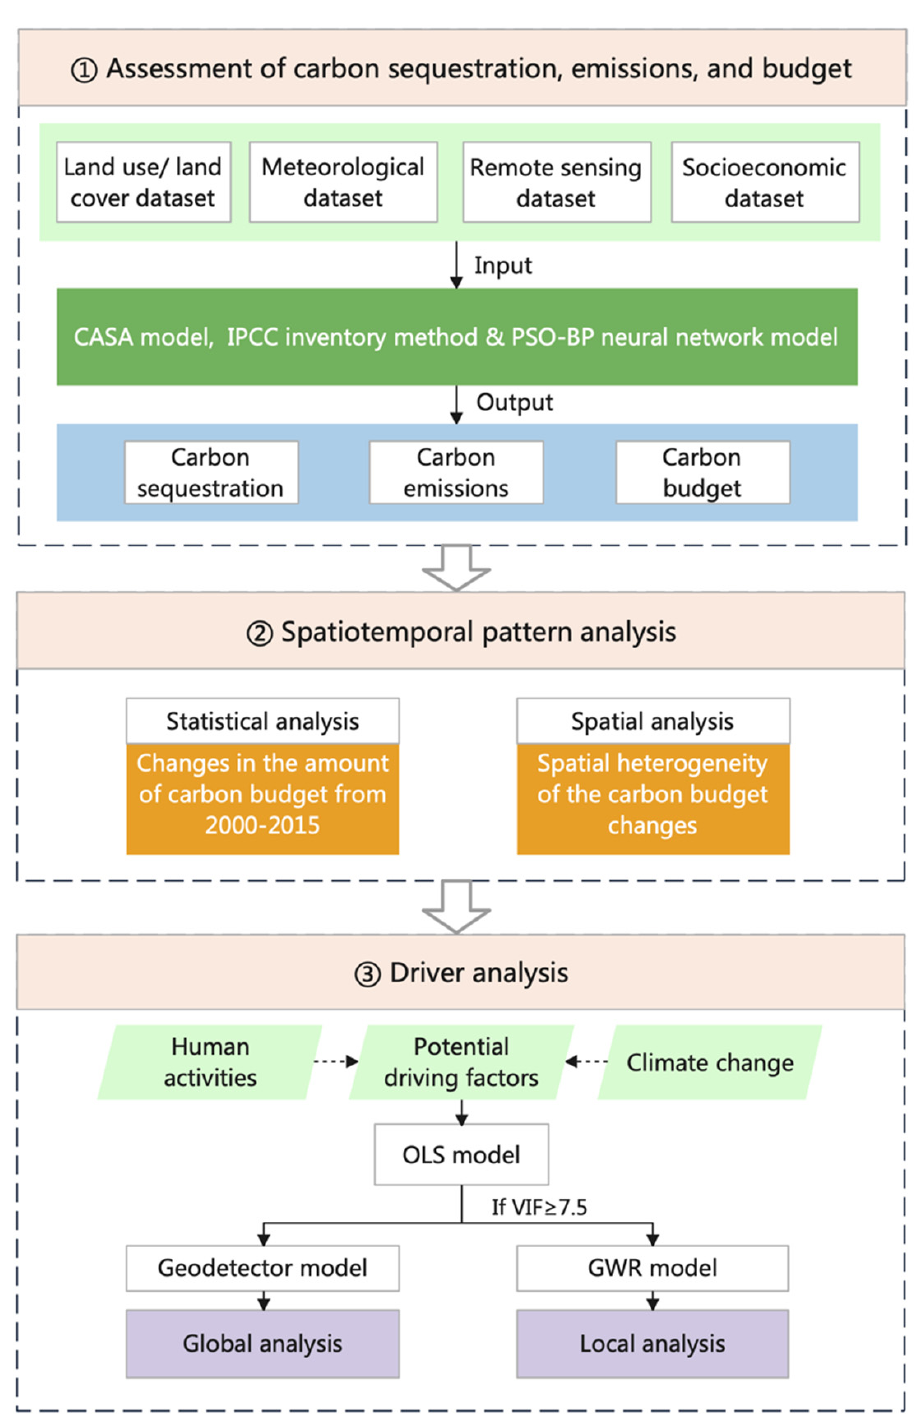
Figure 2. The flow chart of this study.